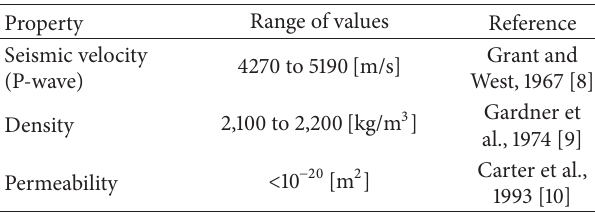
Table 1: P-wave velocity, density, and permeability of the rock salt bodies placed in oil and gas prospecting zones (SI